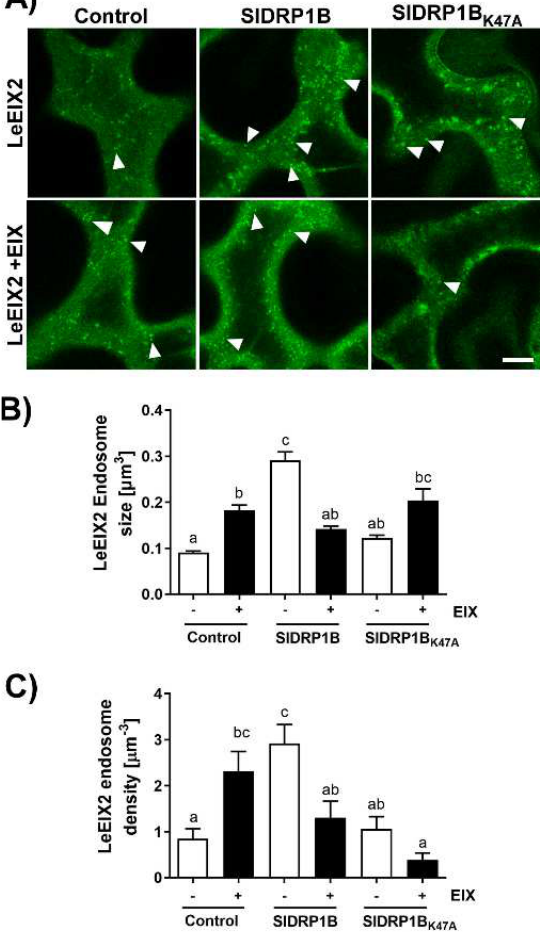
Figure 5. Effect of overexpression of SlDRP1B on LeEIX2 endosomes. N. benthamiana leaves transiently expressing LeEIX2-GFP and free mCherry (control), SlDRP1B-mCherry, and SlDRP1B K47A , as indicated, were treated with EIX (1 µ g mL − 1 tissue) or water (mock) at the petiole 40 h after transformation and visualized after 15 min. ( A ) Images were acquired using Zeiss LSM 780 confocal microscope (40 × objective); arrowheads indicate LeEIX2 endosomes. Scale bar 10 µ m. ( B , C ) Size and density of LeEIX2 endosomes were quantified using 3D Object Counter (Fiji-ImageJ). LeEIX2 endosomes density was normalized to the control average (mock). Four independent replicates of four images were measured (N = 16). Different letters indicate statistically significant differences between samples in a one-way ANOVA, with Tukey’s multiple comparison test; p < 0.05.